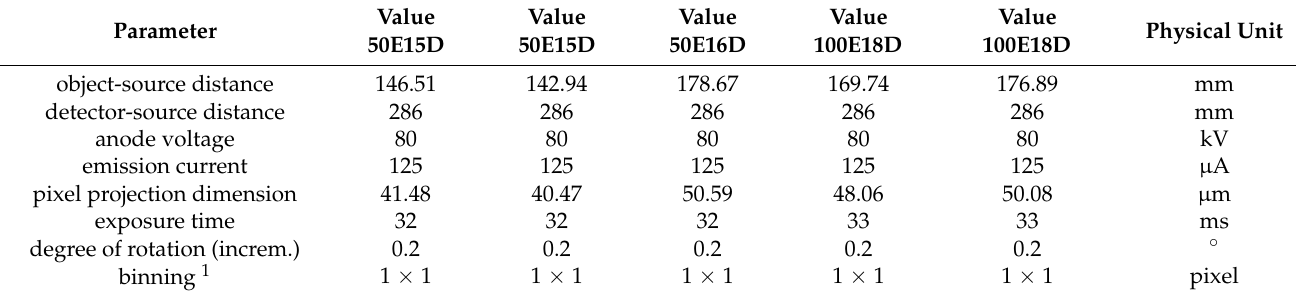
Table A6. Values of set parameters on SkyScan 1275.